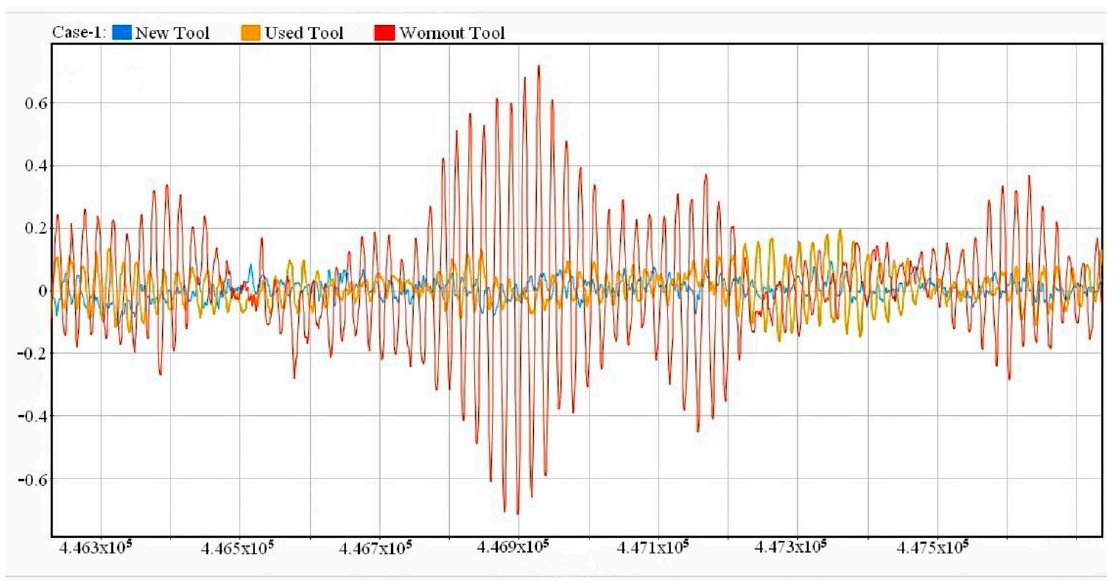
Figure 15. Amplitude comparison of all three categories for Case-1 with new (blue), used (yellow) and worn-out (red) tools are shown.